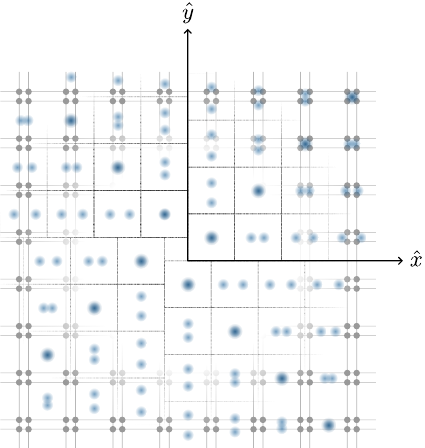
Figure 2: The parametric defect interpolates between the trivial (top right quadrant) and topological (bottom left quadrant) phases of the BBH model (grey dots connected by lines) by smoothly modulating the hoppings and preserving local mirror symme- tries. While in the trivial phase the Wannier centers (blue circles) are localized at the center of the unit cell, they are localized at the corners in the topological phase. In all unit cells the Wannier centers come in pairs invariant under local mirror symmetries. The square cells, each centered in between pairs of nearest Wannier centers, tile the space away from the defect. The unoccupied quarter unit cell at r = 0 corresponds to the missing fractional charge e /